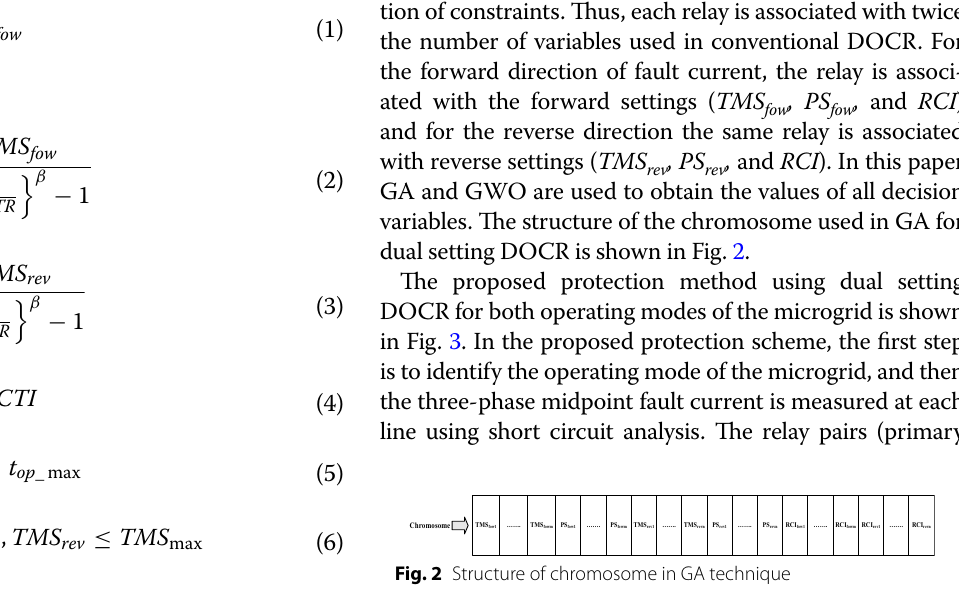
Fig. 2 Structure of chromosome in GA